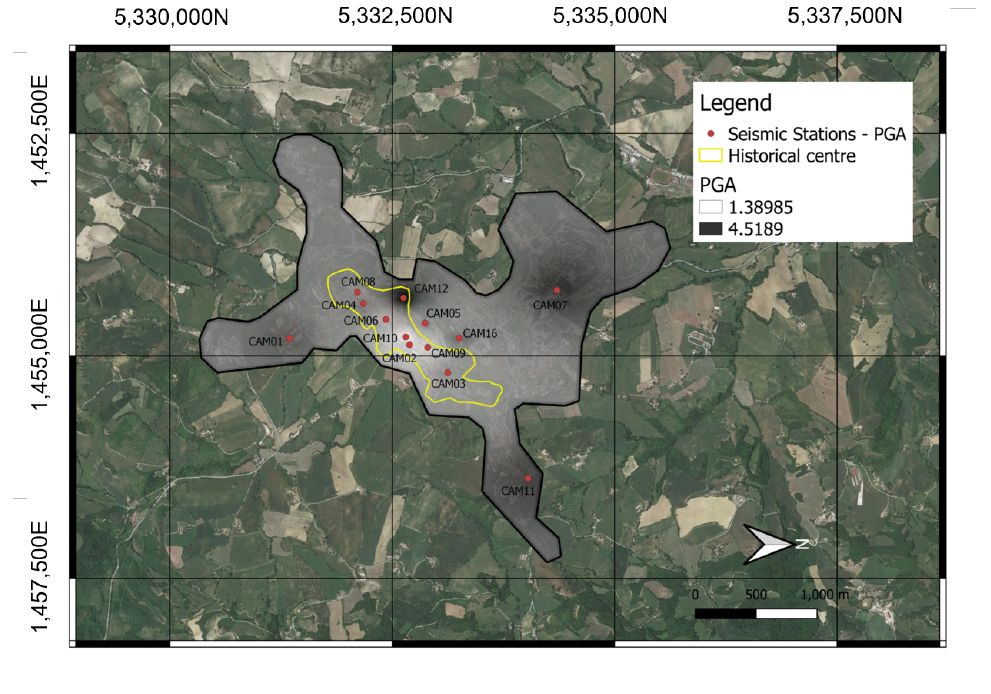
Figure 12. Example of shakemap obtained from the recordings carried out by the MEMS accelero- metric stations during ML 3.3 earthquake, which occurred near Fiordimonte (MC) on 18 April 2021 (adapted from